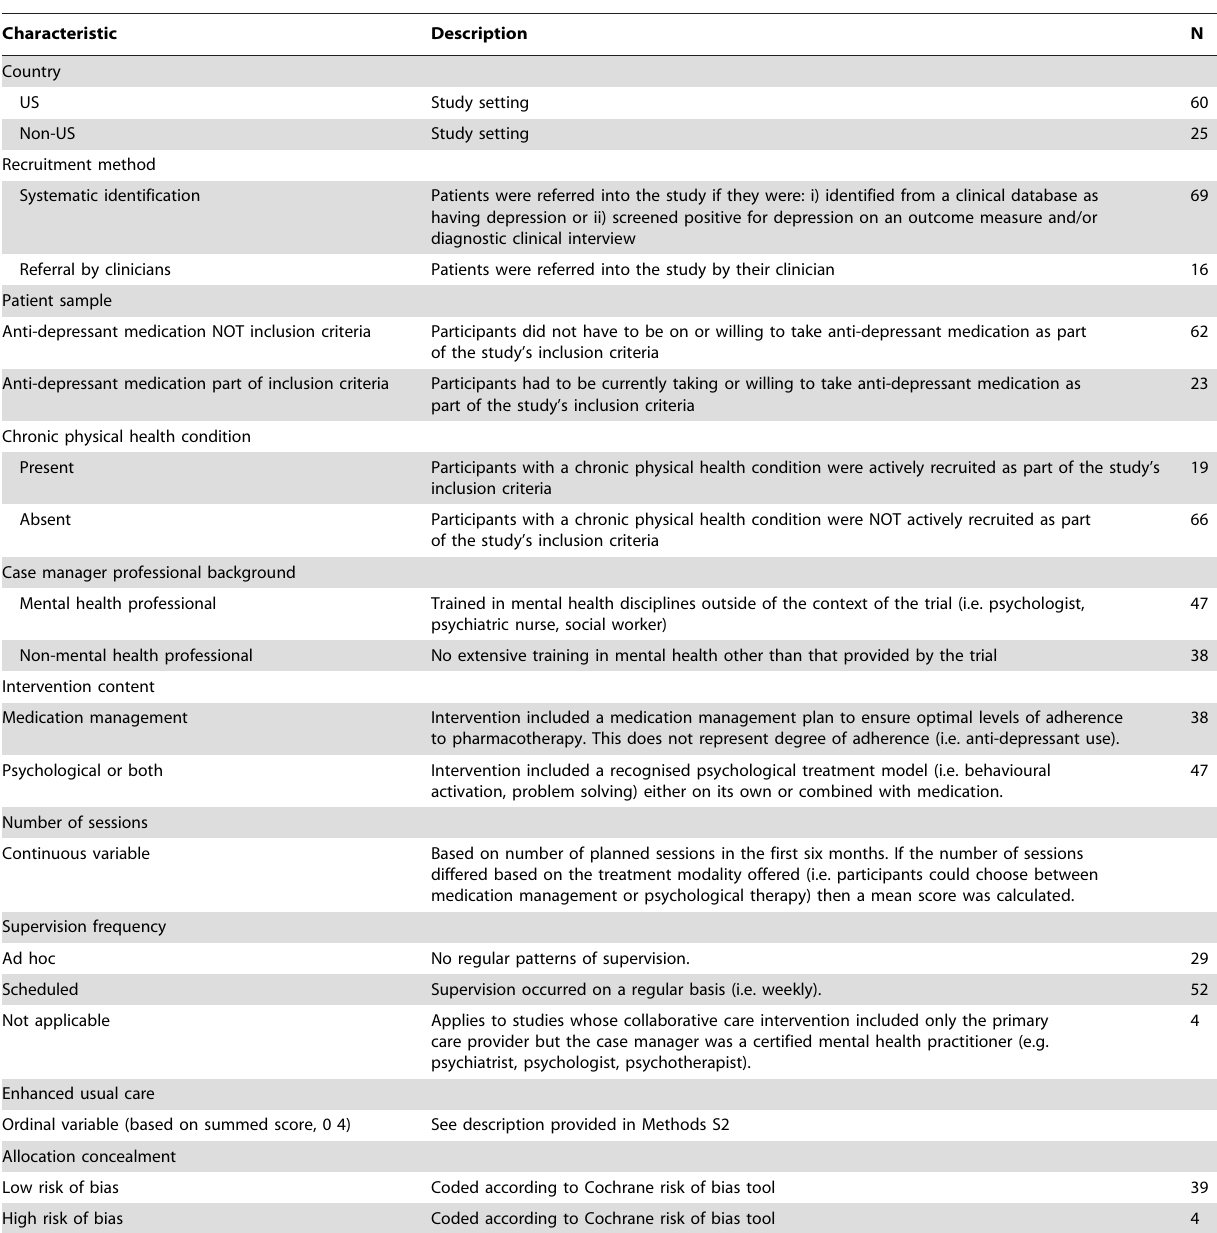
Table 2. Study level covariates (N=85